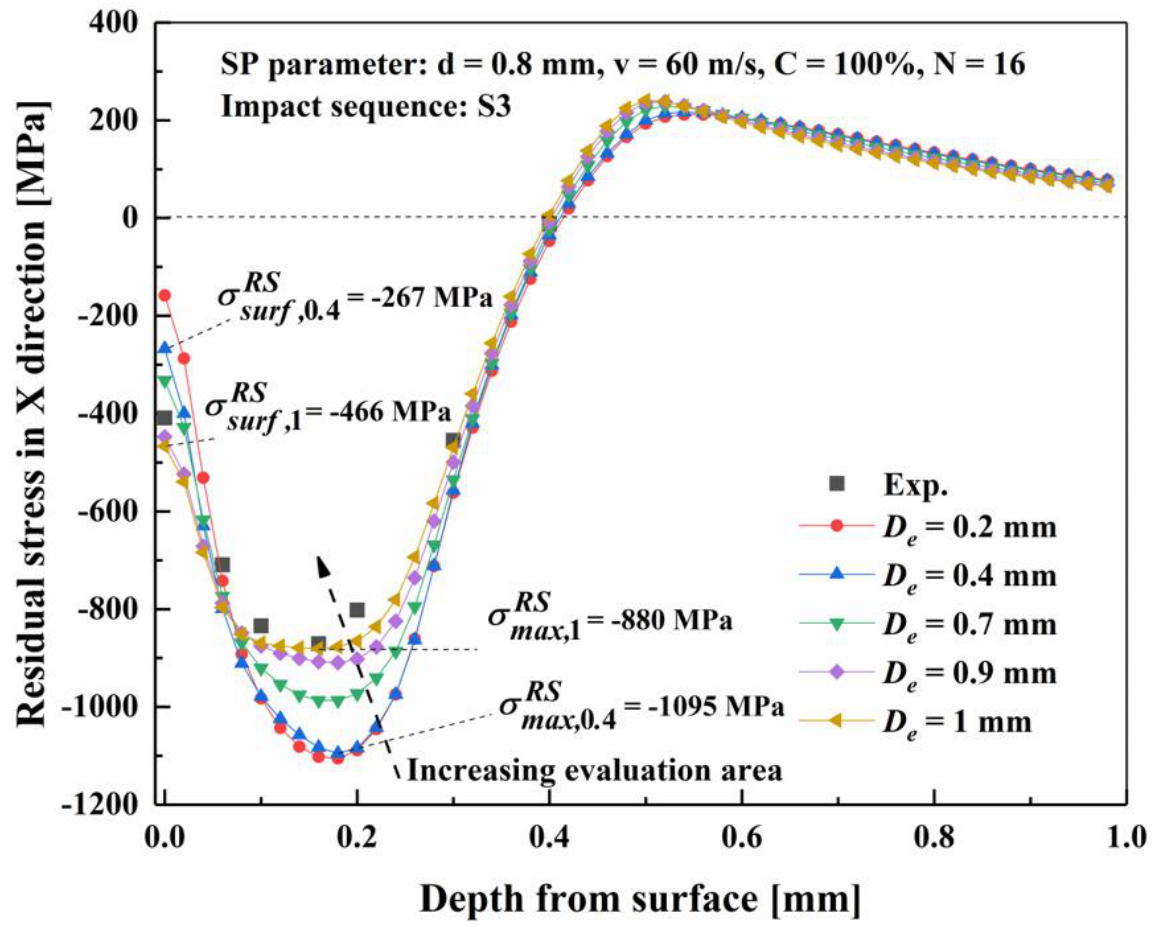
Figure 13. Residual stress depth profile with different evaluation area in order dimple pattern SP model (SP parameter: d = 0.8 mm, V = 60 m/s, C = 100%, N = 16).